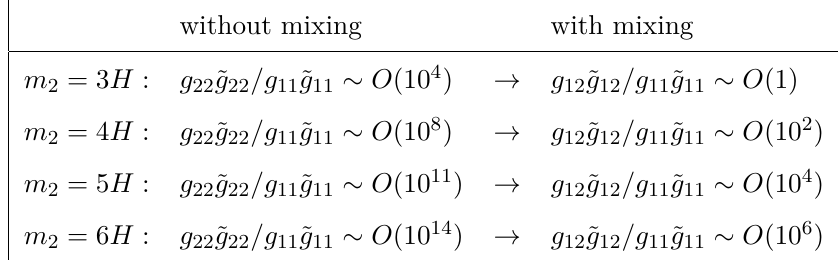
Table 1 . hierarchy in g IJ and ˜ g IJ for non-trivial